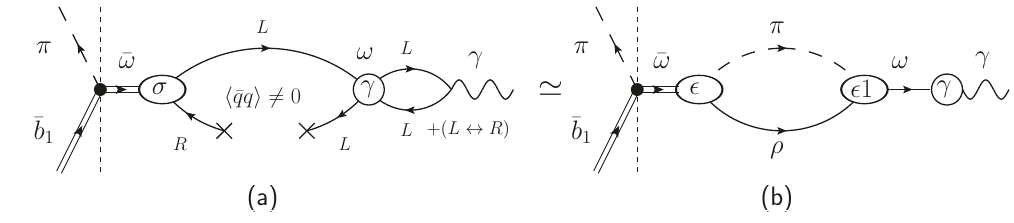
Figure 7 . The decay of ¯ b 1 πγ through the ω (782) state, i.e., the VMD channel. (a) OPE → description via QCD Lagrangian as inferred from eq. (3.21) and (b) hadron interaction picture via anomalous coupling. In (a), the blobs with ‘ σ ’ and ‘ γ ’ represent the tensor and vector current representation, respectively, and the vertex ‘ ǫ ’ and ‘ ǫ 1’ in (b) represent the anomalous hybrid state interpolation (4.20) and the physical interaction vertex (4.19),